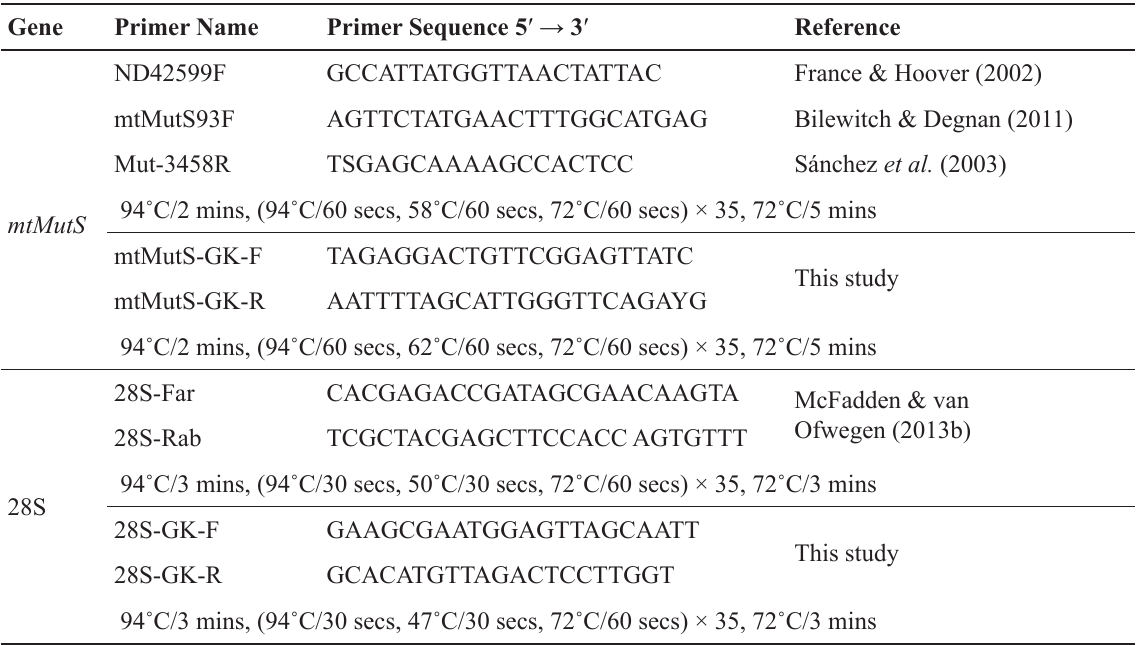
Table 1. Primers and PCR protocols used in this study. PCR protocols are shown underneath their corresponding primer